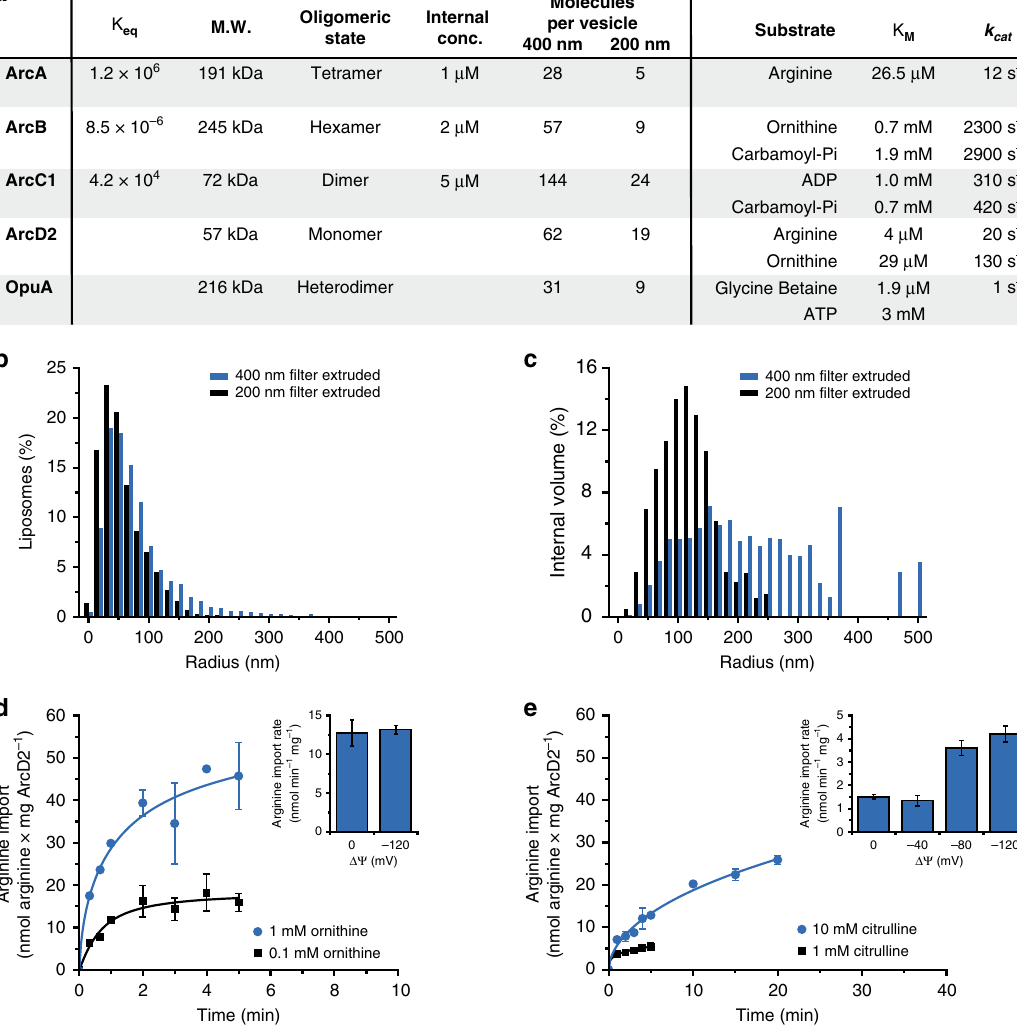
(Fig. 2e, blue line; pyranine calibration shown in Supplementary Fig. 4); the transient in the internal pH is more evident when the internal buffer capacity is decreased (Fig. 2e, black line). The acidi fi cation of the vesicle lumen cannot be readily explained if arginine is solely converted into ornithine (Eq. (1)). Indeed, we found citrulline as an end product in addition to ornithine (Fig. 4a). What is the basis for the futile hydrolysis of arginine? Since external ArcA was inactivated by pCMBS, we infer that part of the citrulline is not metabolized further but exported and